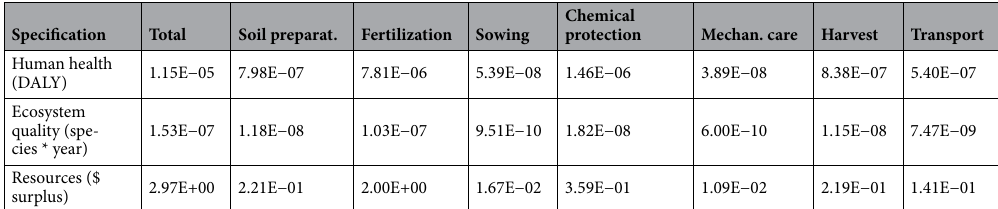
Table 2. Environmental impact related to the use of water in conventional carrot production per area unit